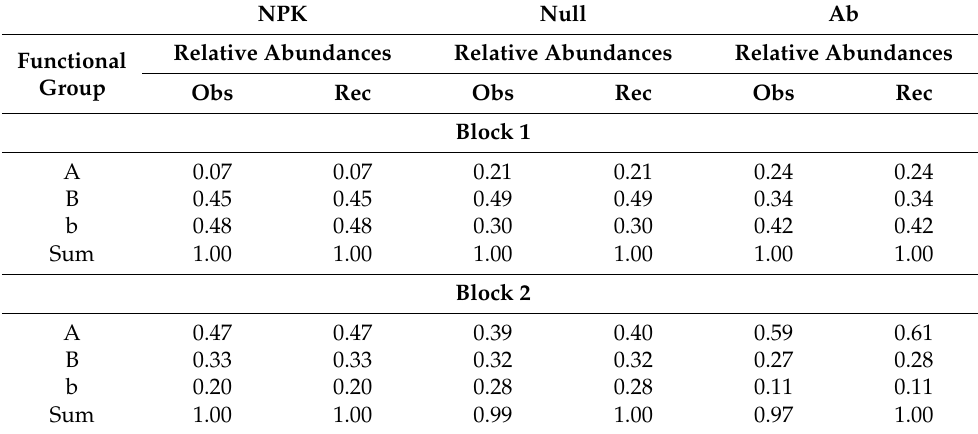
Table 3. Relative abundances of functional groups (grass species in two blocks and three treatments). Mean values observed over the study period (Obs) were recalculated (Rec) with respect to the dominant